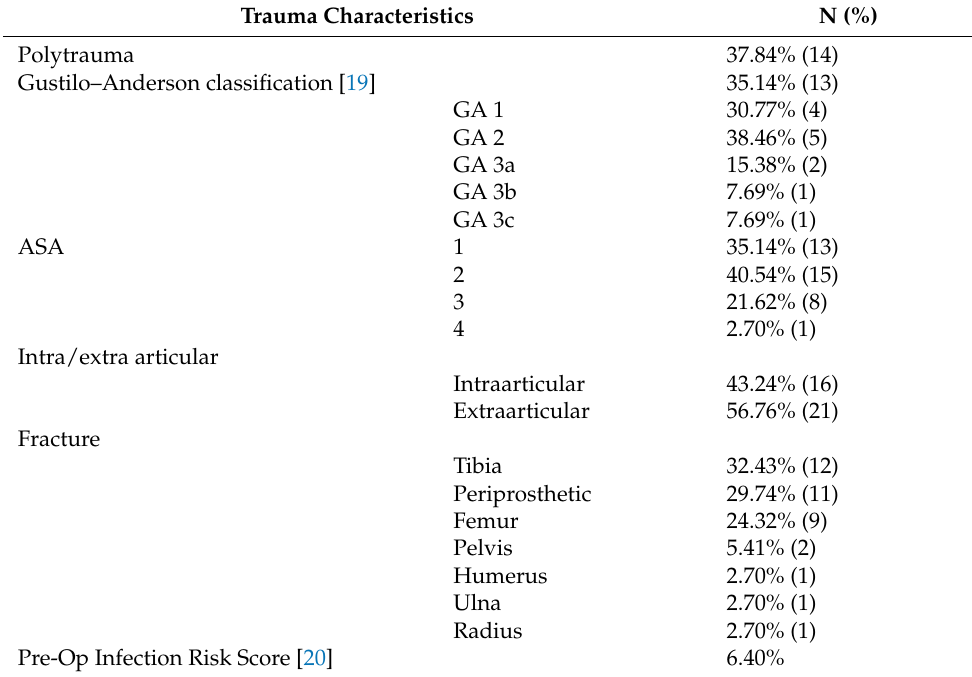
Table 2. Trauma characteristics. GA: Gustilo–Anderson; ASA: American Society of